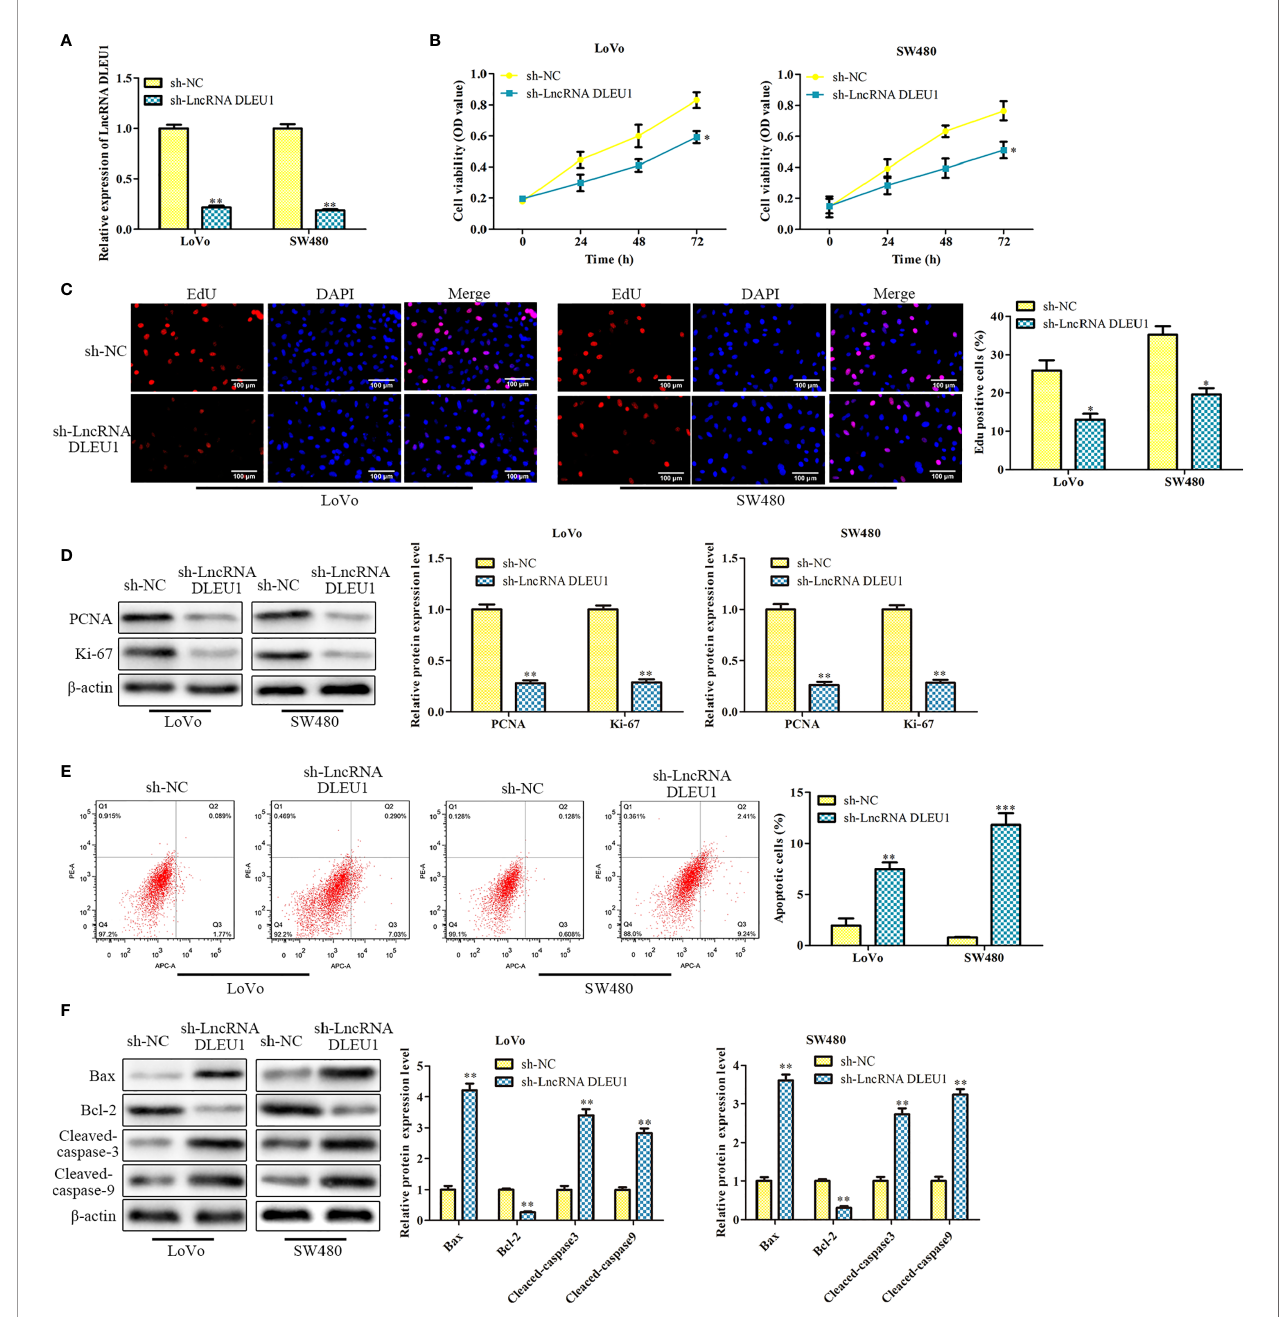
FIGURE 2 | Knockdown of DLEU1 inhibits proliferation and stimulates apoptosis of CRC cells. (A) The relative expression of DLEU1 was determined by qRT-PCR in LoVo and SW480 cells. (B) The cell viability was determined using CCK-8 assay in LoVo and SW480 cells. (C) The cell proliferation was determined using EdU assay in LoVo and SW480. (D) The proliferation-related protein levels of PCNA and Ki-67 were investigated by western blot in LoVo and SW480 cells. (E) The cell apoptosis was determined using low cytometry assay in LoVo and SW480 cells. (F) The apoptosis-related protein levels of Bcl-2, Bax, Cleaved-caspase3 and Cleaved-caspase9 were investigated by western blot in LoVo and SW480 cells. * P < 0.05, ** P < 0.01, *** P < 0.001 vs .